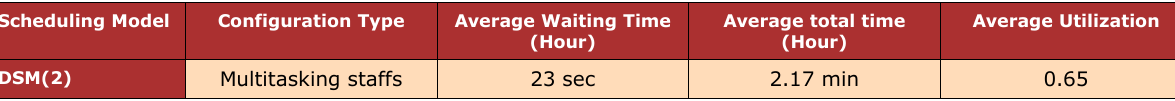
Table 21. Properties of final configuration for settings with low interaction